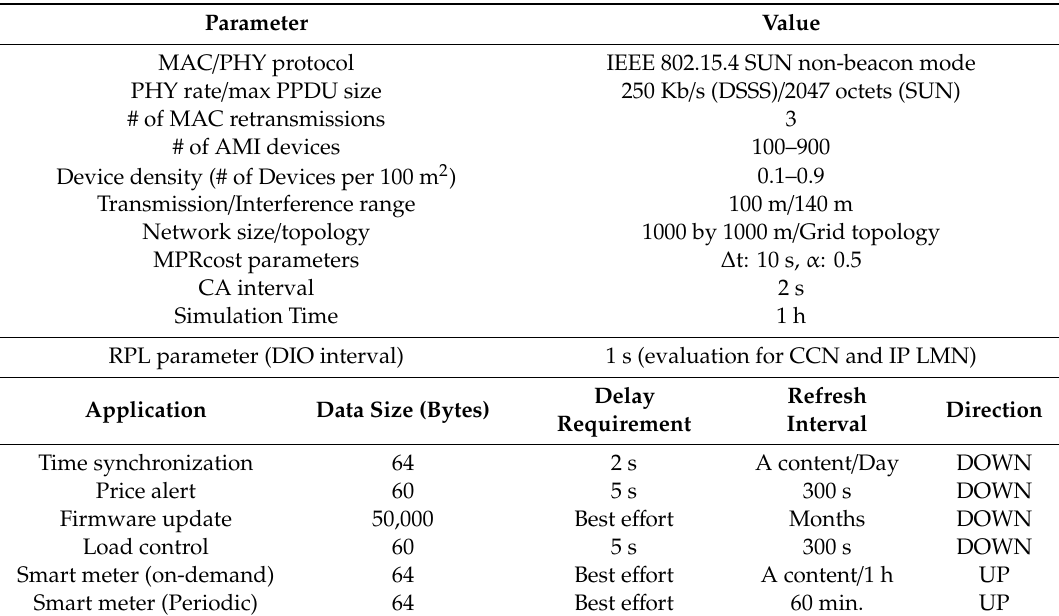
Table 1. Simulation parameters and Smart Grid (SG) application set.